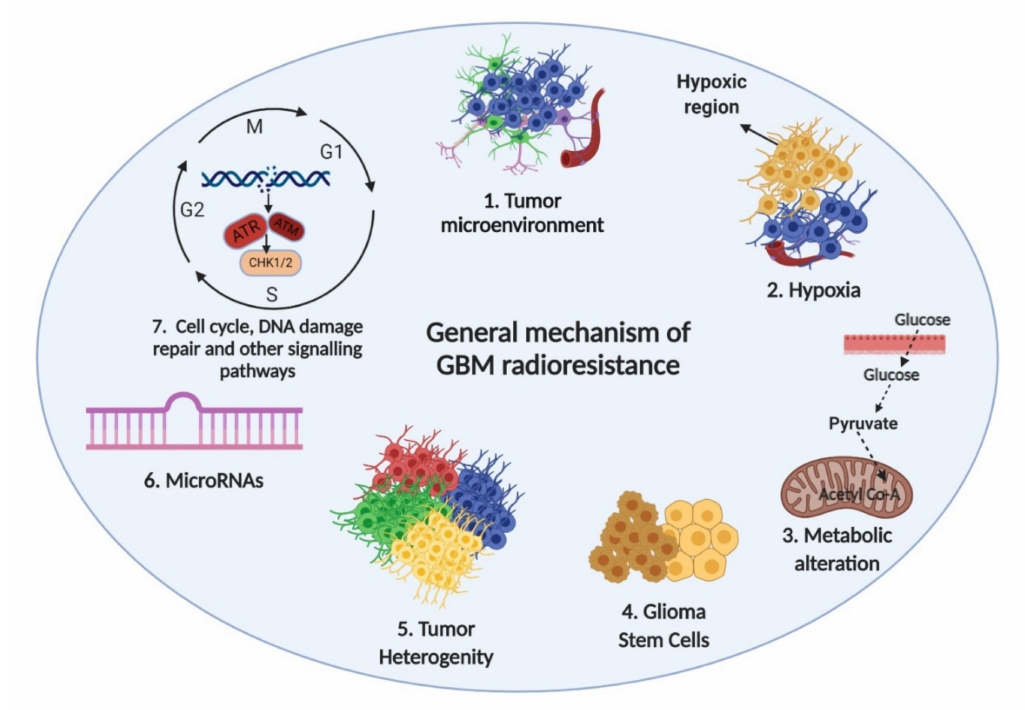
Figure 2. Identified mechanisms of GBM radioresistance. Tumor microenvironment, hypoxia, metabolic alterations, glioma stem cells, tumor heterogeneity, microRNAs, and alteration in cell cycle regulation and DNA damage repair are the most well-defined factors involved in GBM radioresistance. Created with BioRender (Science Suite Inc., Toronto, ON,